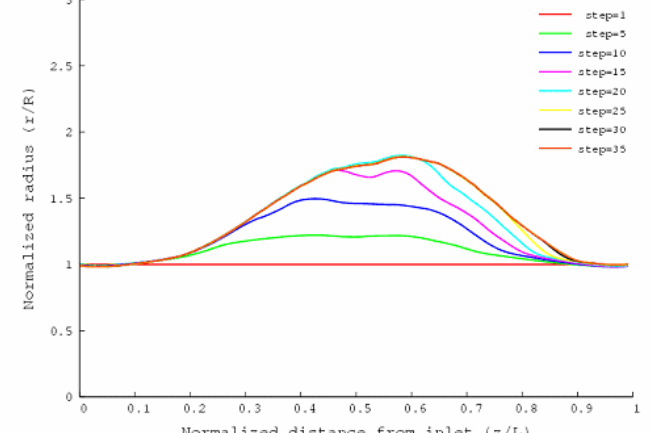
Fig. 8 Plot of the growth of the aneurysm in the curved model. Simulation condition: =50 dyne/cm 2 (5.0 k=1.5 and τ th